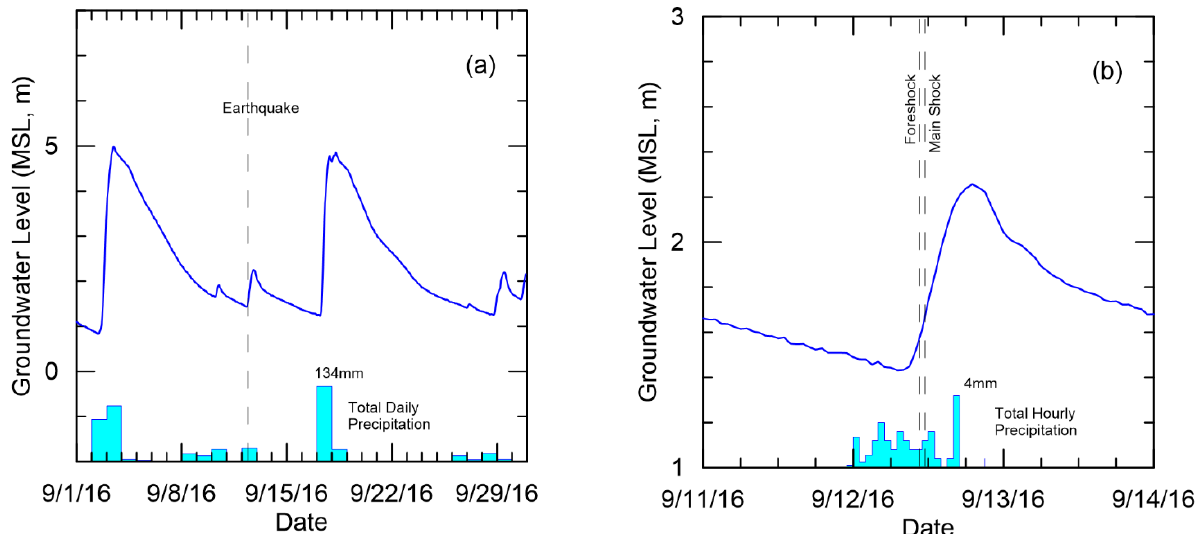
Figure 7. Groundwater level changes for well W2 during ( a ) September 2016 and ( b ) a closer inspection of the 3 days around the earthquake event.